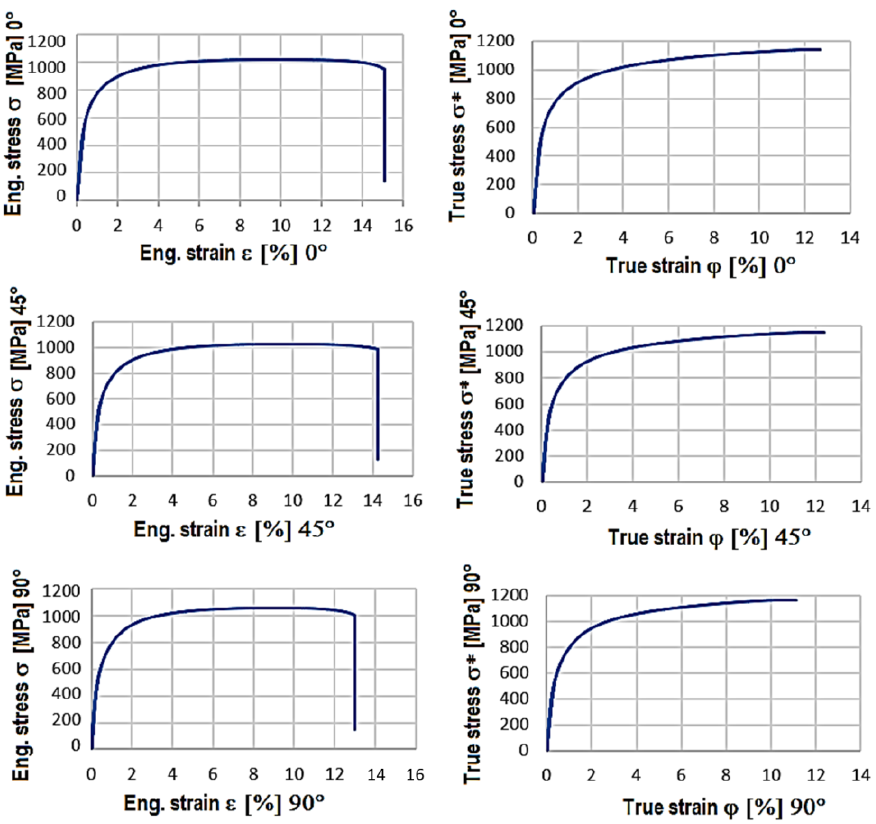
Figure 3. Stress – strain curves: DP980 tensile tests at 0, 45, and 90° (by